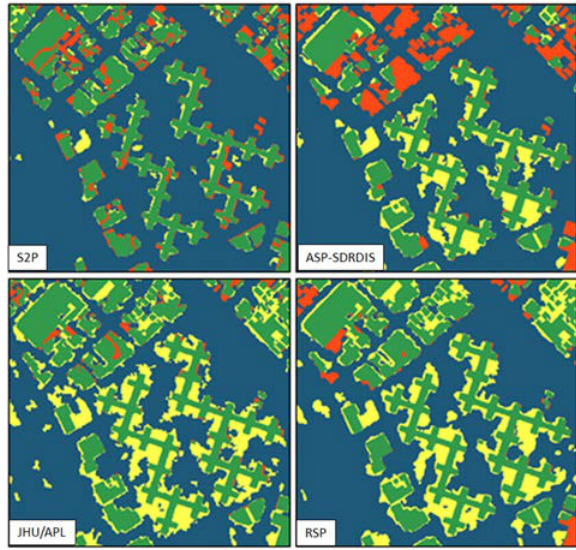
Figure 7 2D building labeling accuracy is shown for MVS point clouds (Green=TP, Yellow=FP, Red=FN, and Blue=TN).